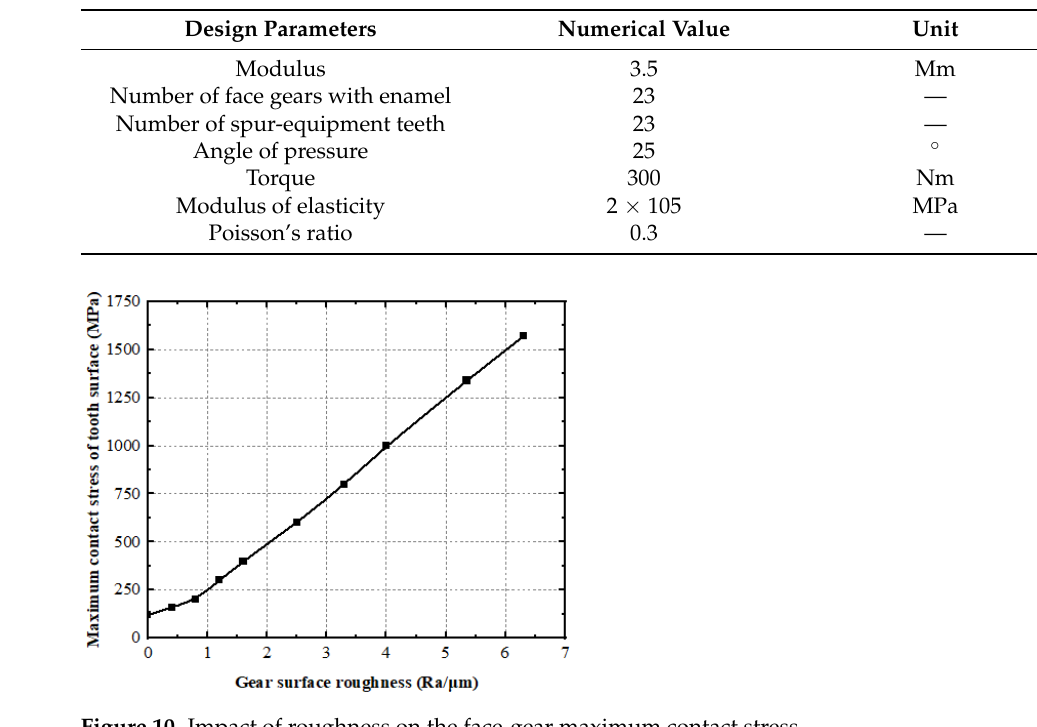
Figure 11. The curve of greatest contact stress at the contact point of the face gears.